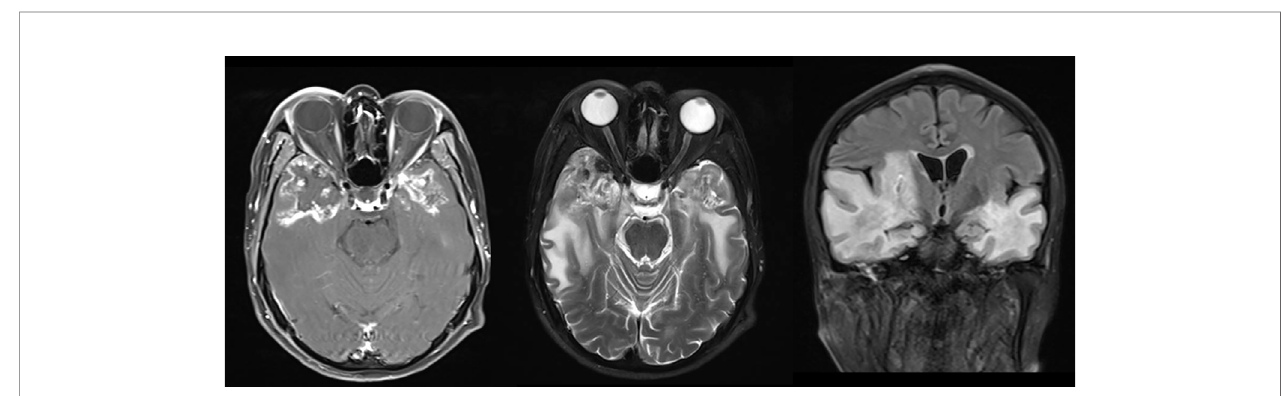
FIGURE 1 | Typical MR images of radiation-induced temporal lobe injury